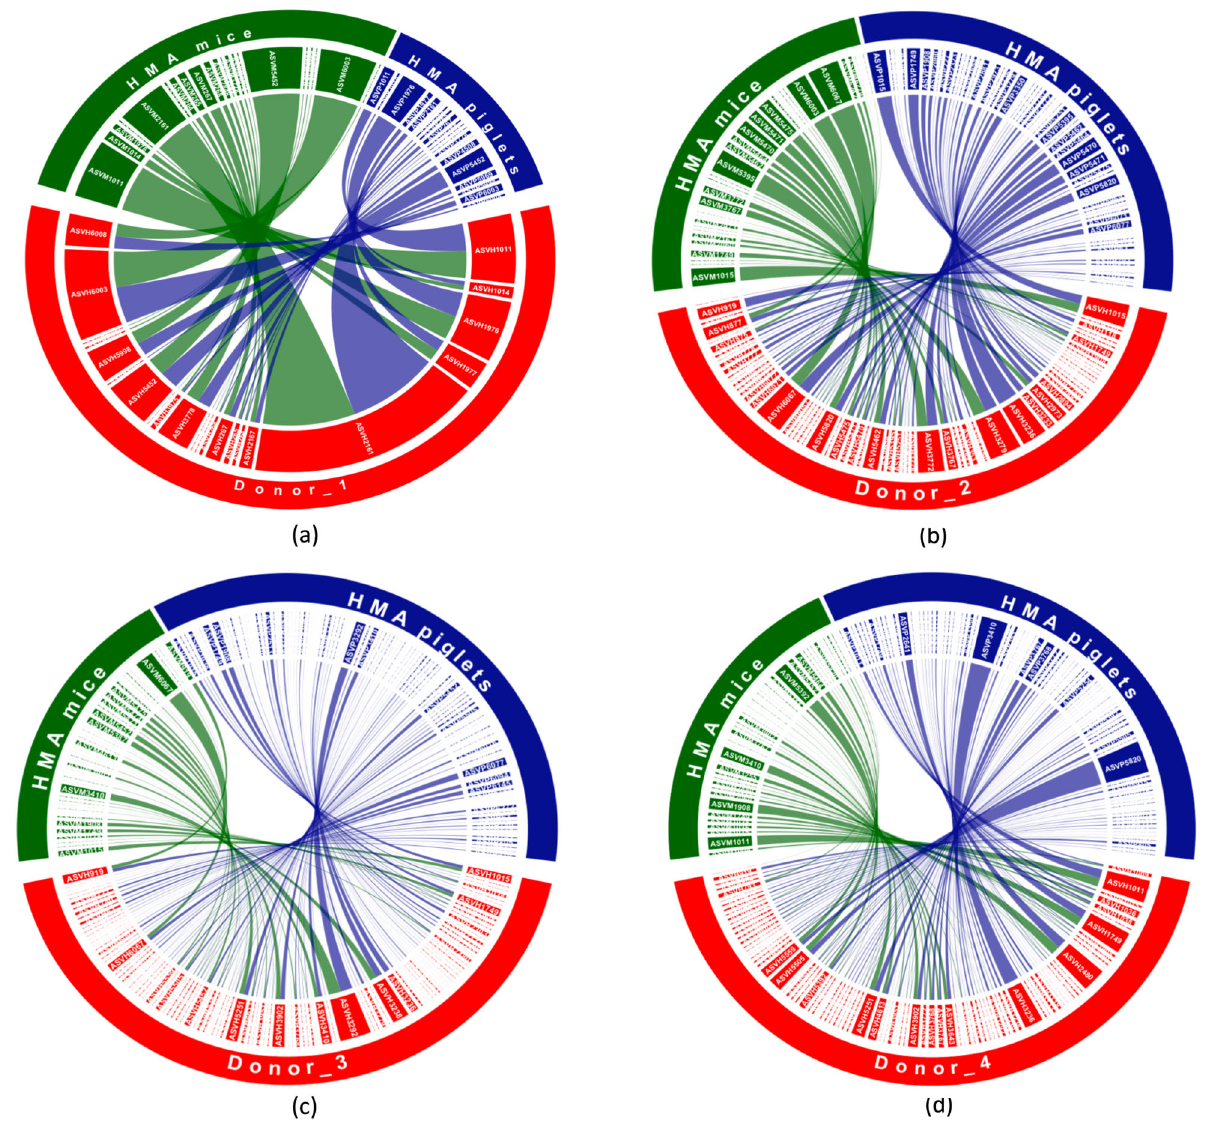
Fig. 5 Chord diagram representing the colonization patterns of core donor ASVs in the two HMA animal models. ( a ) Donor_1, ( b ) Donor_2, ( c ) Donor_3, ( d ) Donor_4. Each sector represents an ASV and the size of the sector corresponds to the mean relative abundance of that ASV in the host species. Links indicate which core donor ASVs established in each animal model and the widths at each end of a link are proportional to the abundance of that ASV in the respective host species. Core donor ASVs which failed to colonize both HMA animal models are not shown. ASVs have been designated according to the following example: ASV_1 is ASVH1 in human donors, ASVM1 in HMA mice, and ASVP1 in HMA piglets. n = 13 (3 piglets/donor, with the